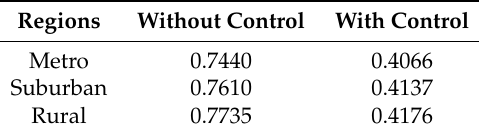
Figure 7. MRSA model simulation with no movement. ( a ) Infected individuals in large metro area, ( b ) Infected individuals in suburban area. ( c ) Infected individuals in rural area. Parameter values used are given in Tables 2 and 3. Table 6. Proportion of infected individuals at the end of simulation period when controlling behavior in isolated